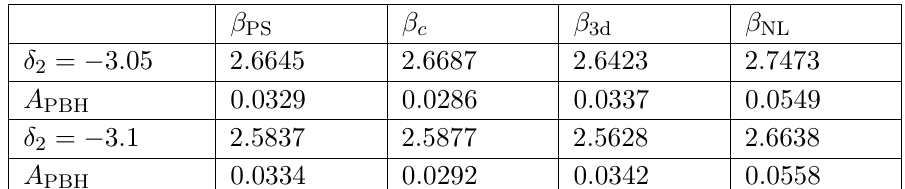
Table 1 . The duration of the USR phase, N ∗ , and the corresponding spectral amplitude, A PBH , for realizing PBH as all dark matter f